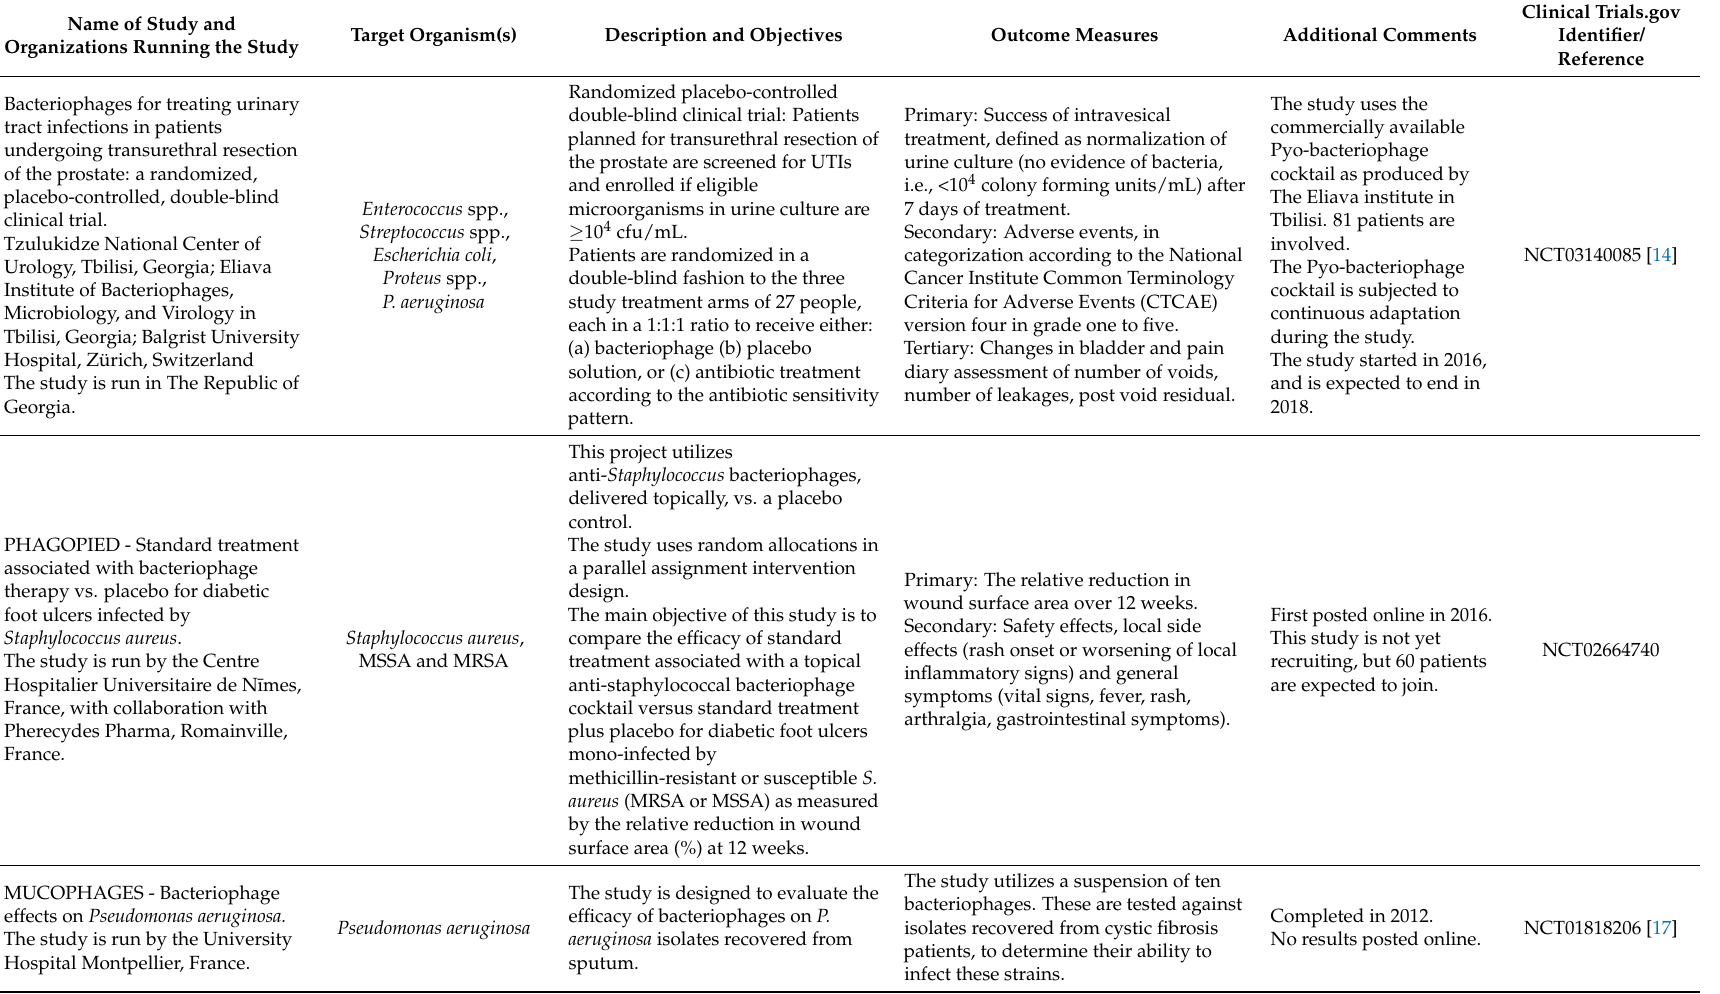
Table 1. Overview of bacteriophage therapy clinical